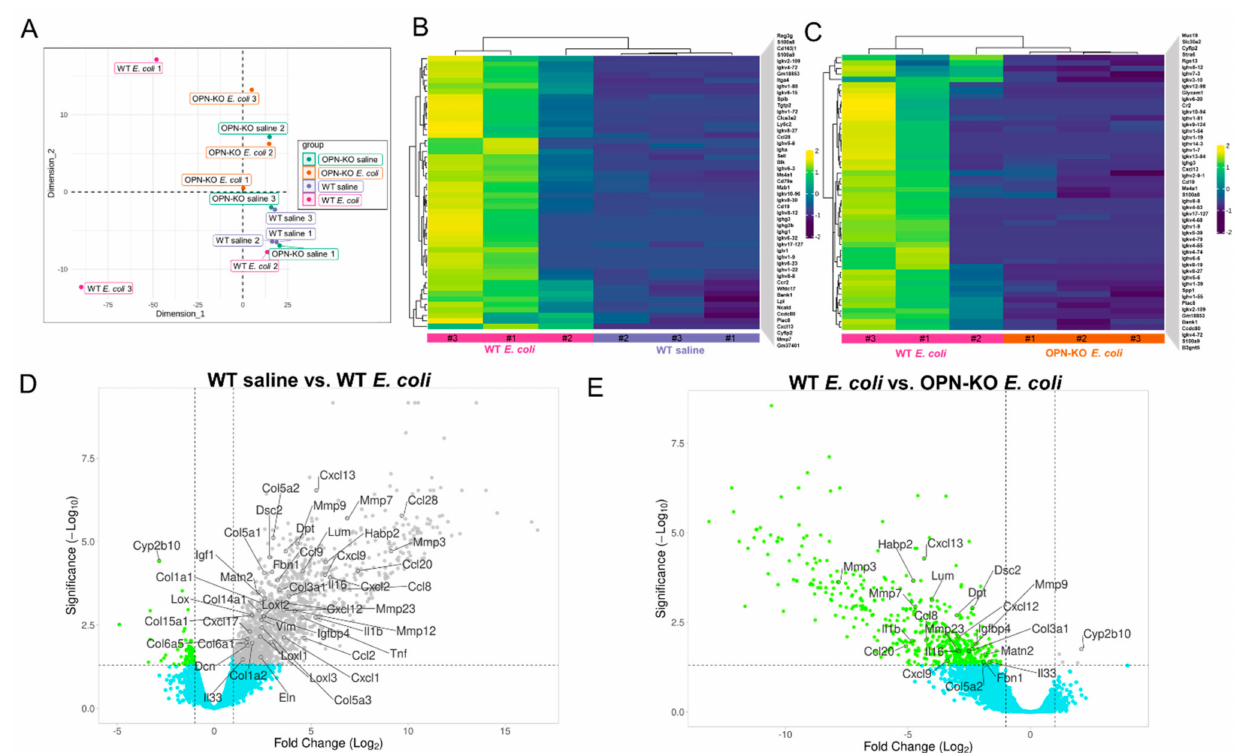
Figure 7. Osteopontin (OPN) deficiency obliterates the chronic inflammatory and pro-fibrotic gene expression signature related to E. coli infection. Panel ( A ) shows an unsupervised multidimensional scaling plot based on RNA-seq of triplicate samples from wild type (WT) saline, WT E. coli , osteopontin knockout (OPN-KO) saline and OPN-KO E.coli experimental groups. This plot demonstrates that two of the three WT E. coli samples differ greatly from the rest of the tissues. Similarly, hierarchical clustering analyses shown in Panels ( B , C ) with WT saline vs. WT E. coli and WT E. coli vs. OPN-KO E. coli contrasts demonstrate that 2 tissues of the WT E. coli group cluster differently, which is likely due to a more robust inflammation developed in these samples compared to the third tissue. Panel ( D ) shows a volcano plot with selected pro-inflammatory and pro-fibrotic DEGs that are significantly increased in response to bacterial instillation in WT mice. We also highlighted a gene, Cyp2b10, that is downregulated in this condition. Panel ( E ) identifies which of the selected genes are downregulated (or upregulated in the case of Cyp2b10) in OPN-KO E. coli